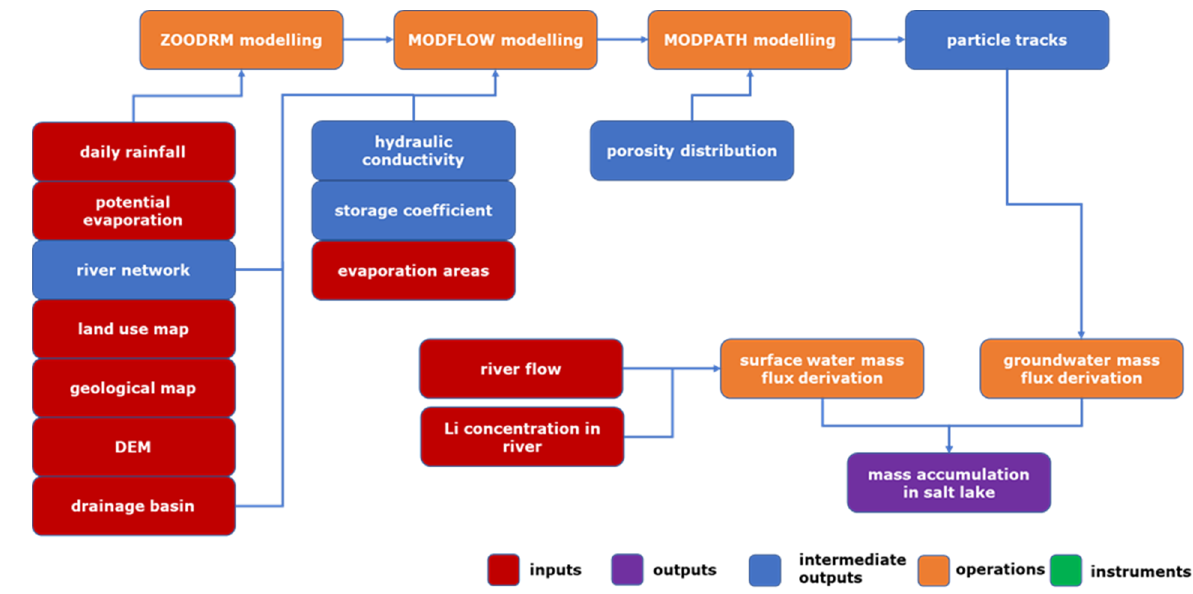
Figure 10. Mass balance framework.